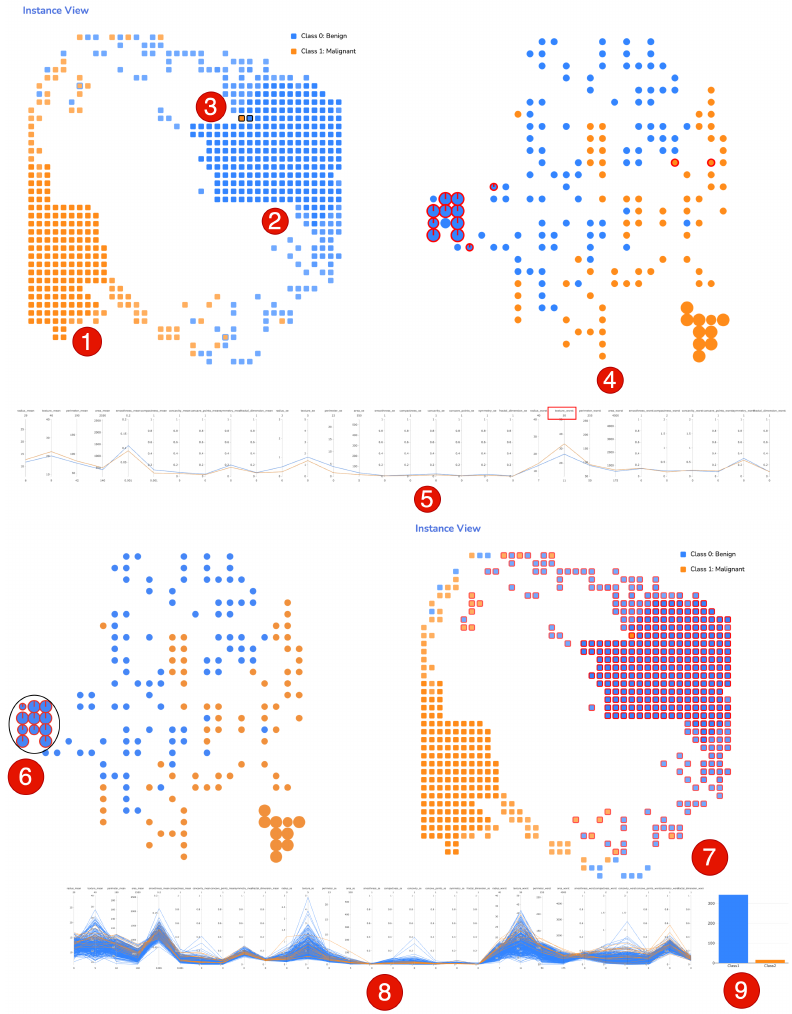
Figure 5. RFMap system with Breast Cancer dataset. (1 and 2) RF model clearly separates most of the instances based on predicted classes and forms two clusters. (3) Misclassified instance 136 and its neighbor 161 selected. (4) Rules used by the instances highlighted in the Forest View . (5) Parallel coordinate shows the difference between the two selected instances. (6) A lasso-drawn to understand a ‘knowledge cluster’. (7) Instances using the ‘knowledge cluster’ highlighted in the Instance View . (8) PCP shows the knowledge content defined by the cluster. (9) Bar chart displays the count per class for all instances using the ‘knowledge